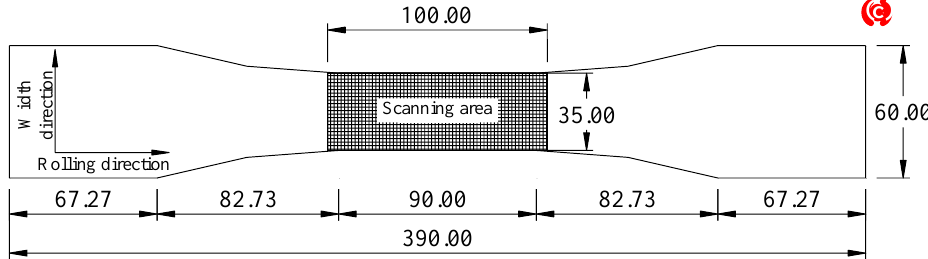
Figure 2. Three-dimensional surface profile measurements: ( a ) photograph of corroded steel plates after removing corrosion products, ( b ) photograph of surface morphology scanning test, ( c ) dimensions of cut dog-bone specimen and scanning area (mm).